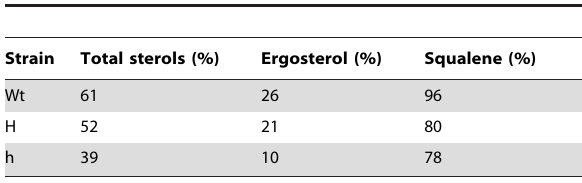
Table 1. Decrease in sterols and squalene after simvastatin treatment.